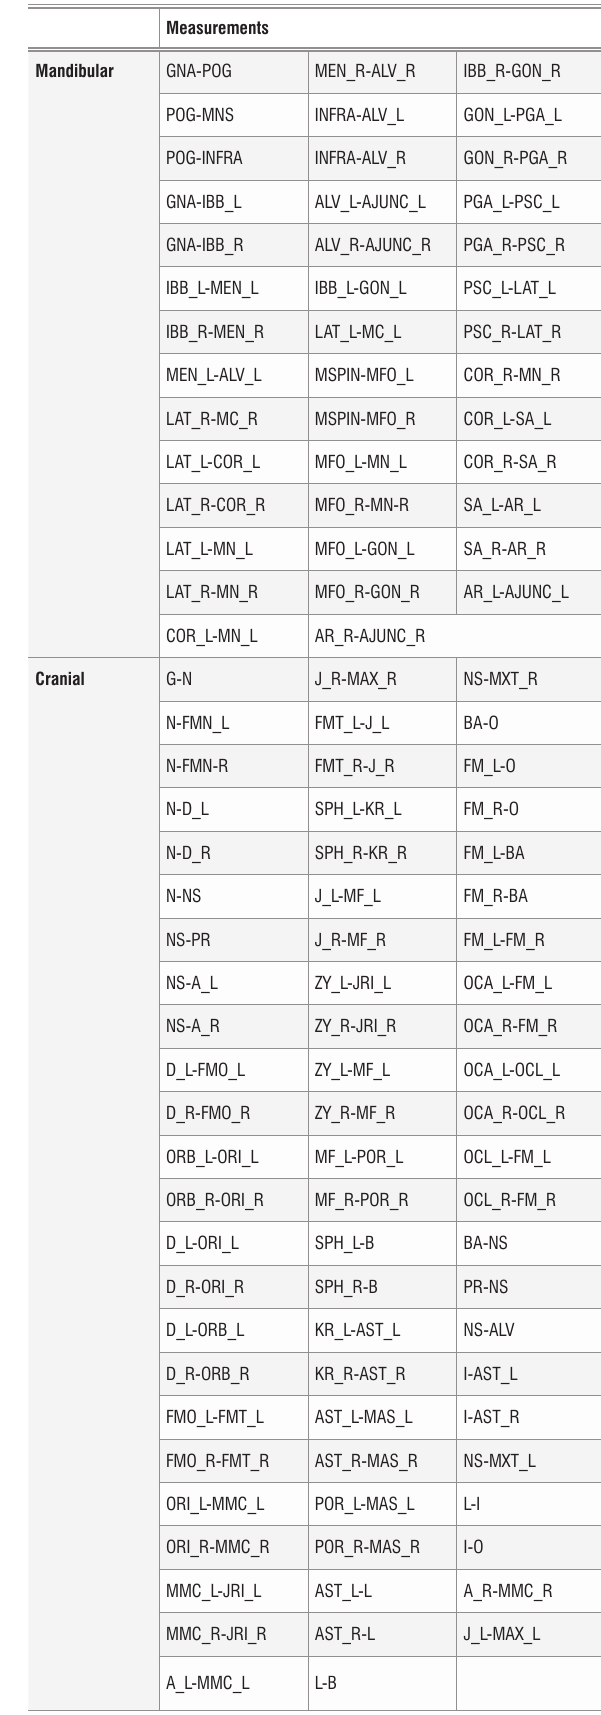
Table 2: Craniomandibular